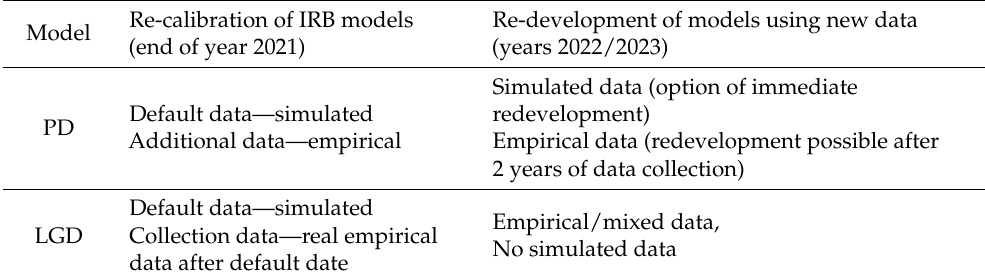
Table 1. Types of data